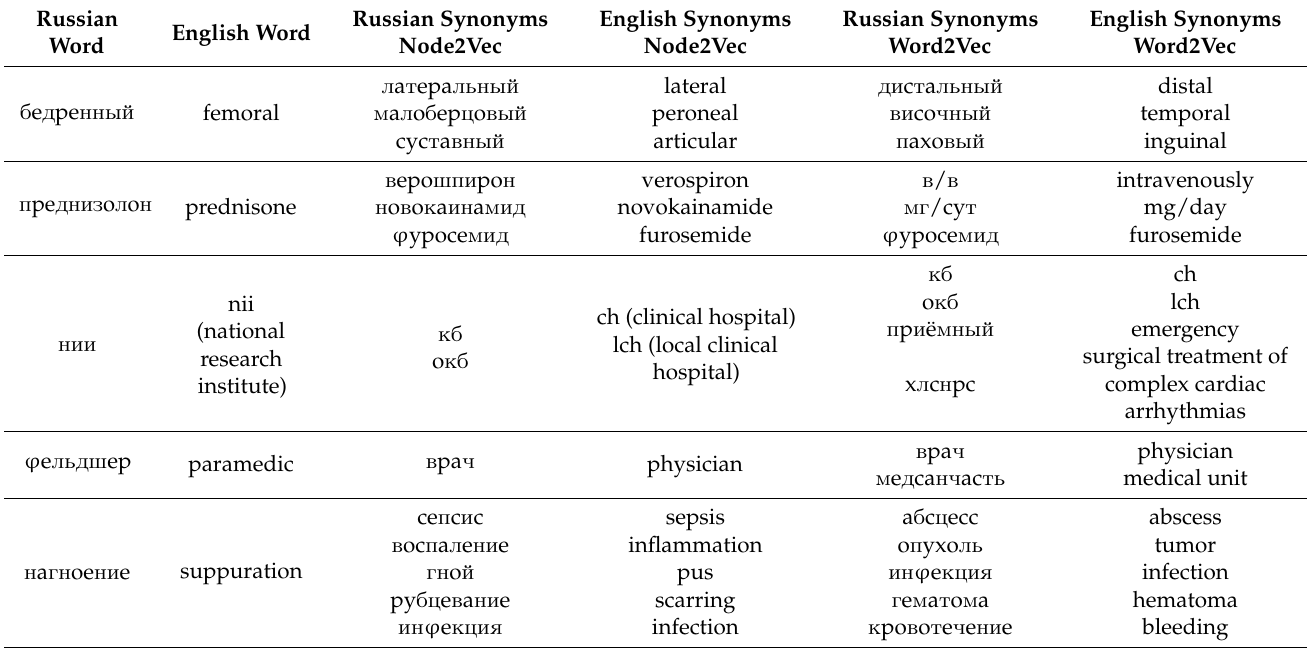
Table 1. Comparison of words similar by cosine distance defined by Node2Vec and Word2Vec